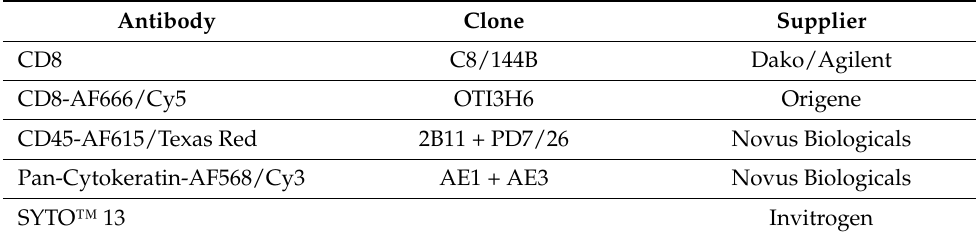
Table 1. Antibody panel employed for cell